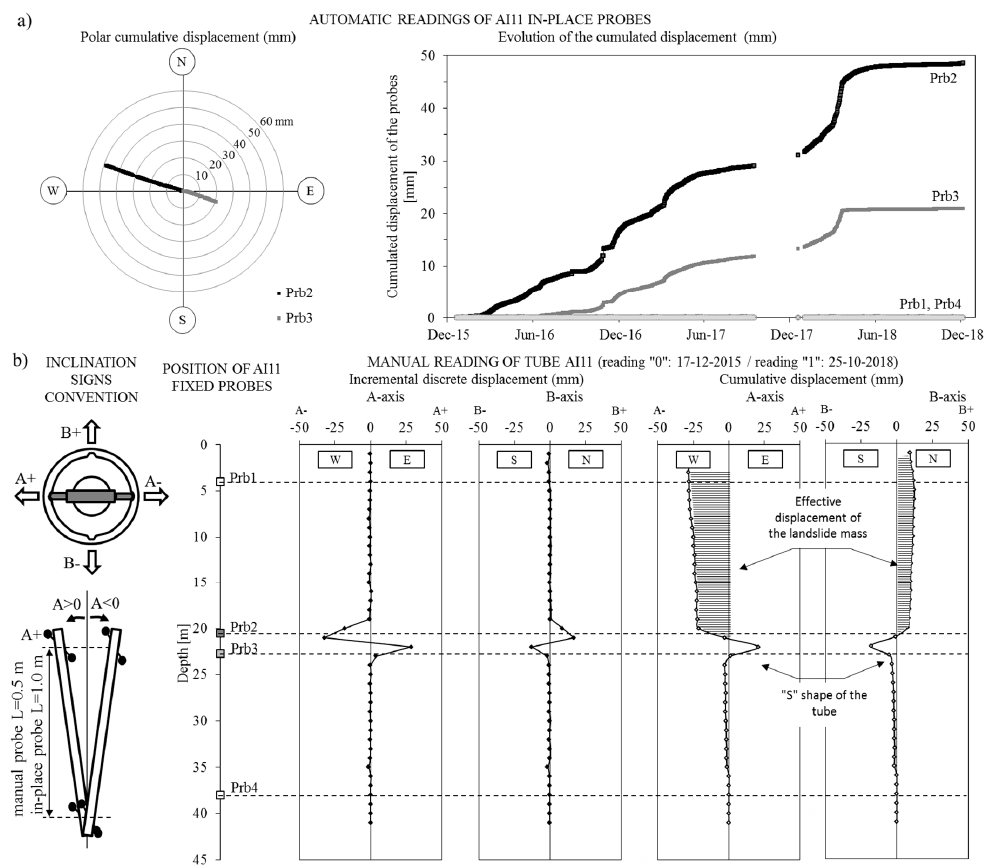
Figure 6. ( a ) Automatic readings of A11 with in-place probes: polar cumulative displacements and evolution in time of the cumulated displacements; ( b ) inclination signs convention of the inclinometer probe, position of the in-place probes along the AI11 casing and results of the manual reading of tube AI11.